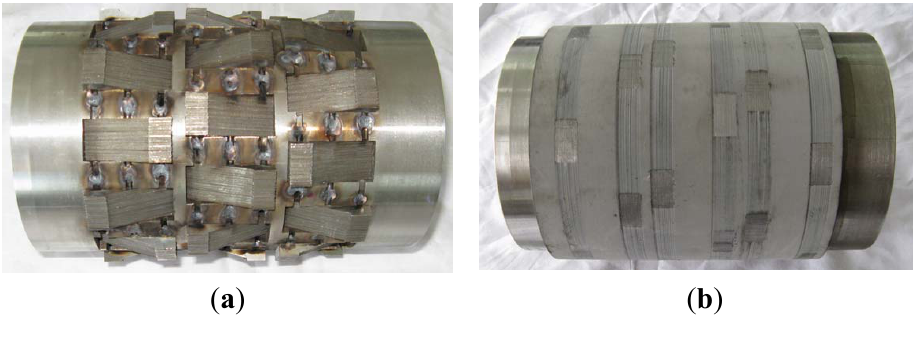
Figure 13. Permanent-magnet rotor core.